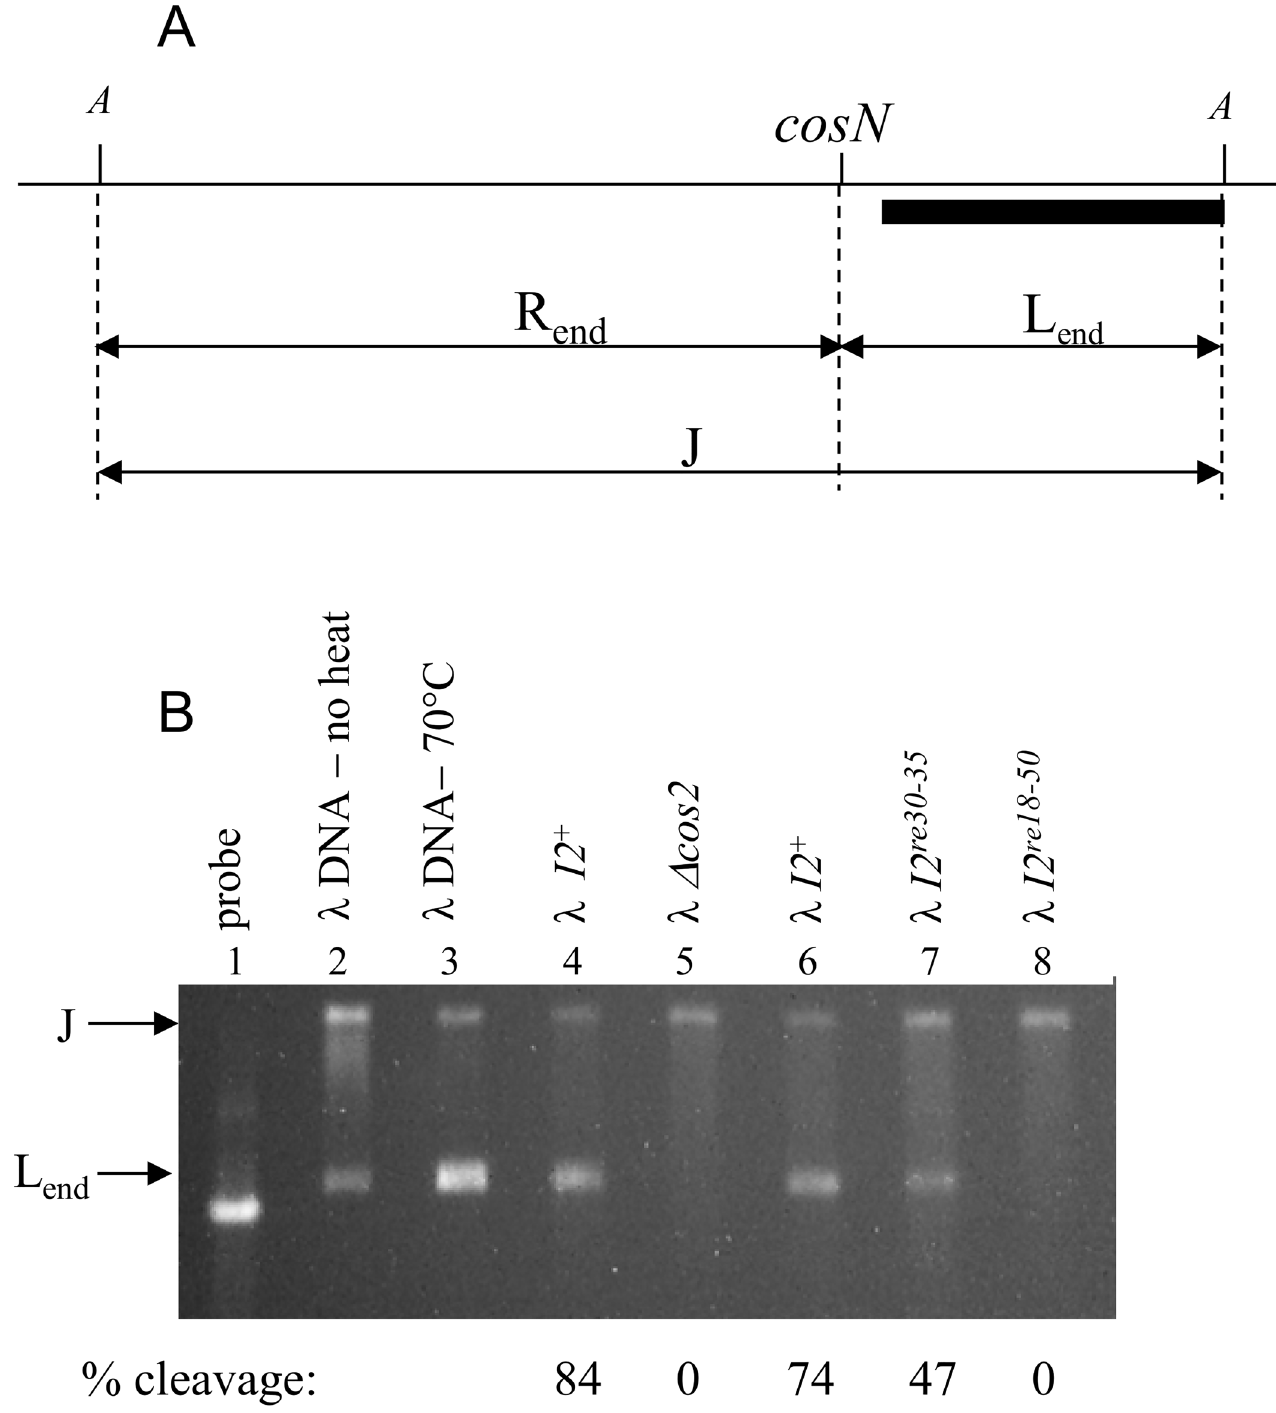
Fig 5. Effects of I2 mutations on in vivo cos cleavage. A. Rationale of the in vivo cos cleavage assay. Total phage nucleic acids were isolated from λ -infected cells. AccI digestion of intracellular DNA not cut at cos results in a 7681 bp-long joint DNA fragment (J). cosN cleavage generates 5591 bp right (R) and 2190 bp left (L) end pieces. In an infection by a mutant that is able to cut cos and form complex I, but is unable package DNA, the uncut J and cut L fragments can be detected. AccI-cut total DNA was electrophoresed on a 0.8% agarose gel and transferred to a membrane for southern blotting. B. AccI digested intracellular DNAs: lane 1 is the DNA probe used for Southern blot assay ( λ bp 177 – 2099). Lanes 2 and 3 are AccI-cut λ DNA loaded on the gel before (lane 2) and after heat treatment at 70°C for 10 min to melt the cohesive ends (lane 3). Phage DNAs from